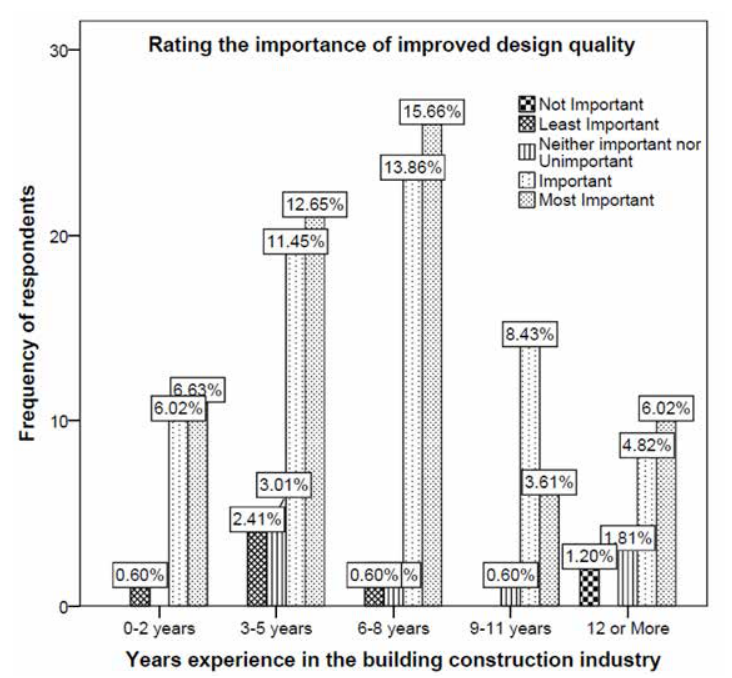
Figure 4: Years of experience versus improved design quality Years of experience versus improved design